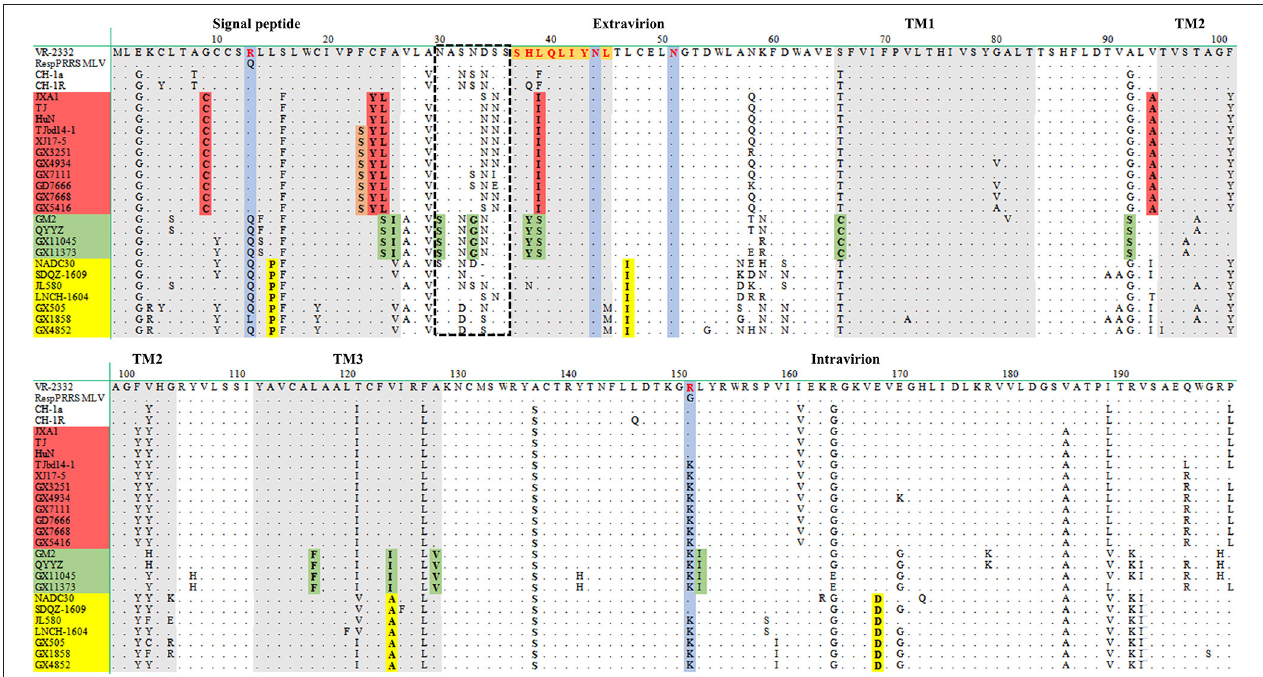
FIGURE 5 | Alignment of the GP5 amino acid sequences of the eleven PRRSV isolates. The signal peptide, PNE and three transmembrane (TM) domains are shown in gray. Identical mutations of highly-pathogenic strains, QYYZ-like strains, and NADC30-like strains are shown in red, green and yellow, respectively. Variable region of NGSs is shown in dashed black